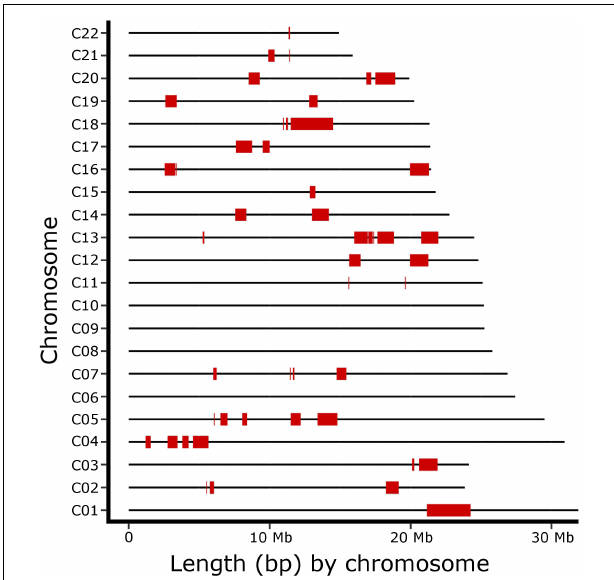
FIGURE 3 | Runs of homozygosity islands genome distribution in the broodstock population. Each ROH island (ROHi) is represented by red segments across turbot ( S . maximus )